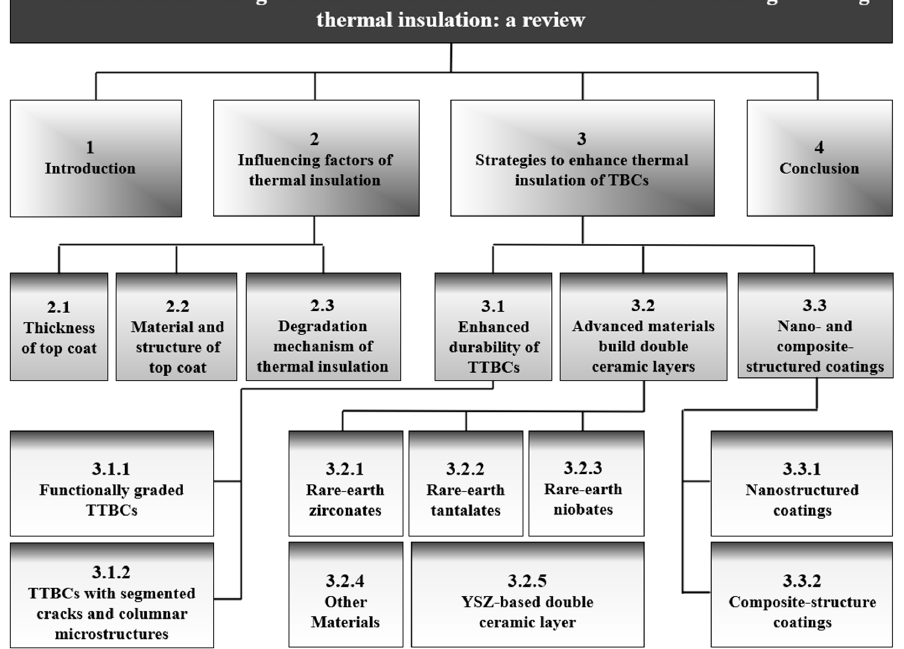
Figure 3. Breakdown structure for the brief review.